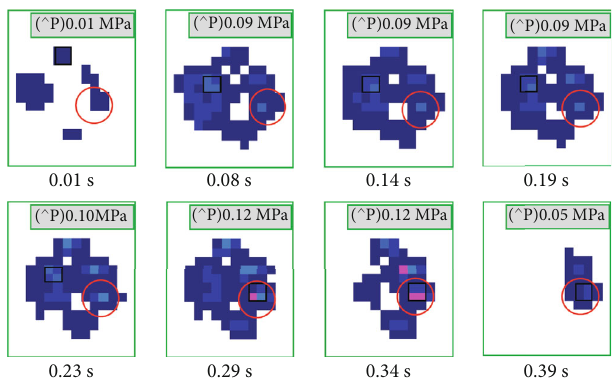
Figure 5: Process of cat forepaw contact at 0.80m/s.